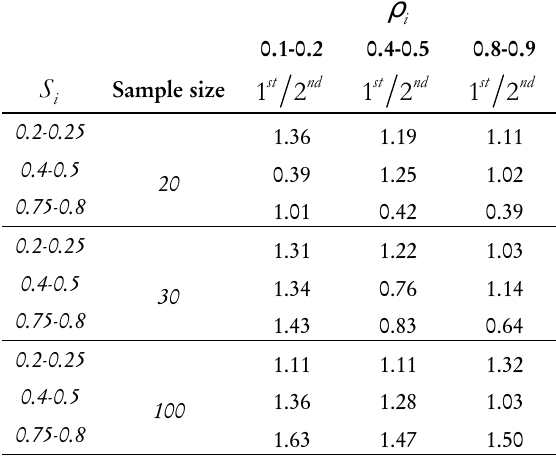
r i and sample size - Normal error